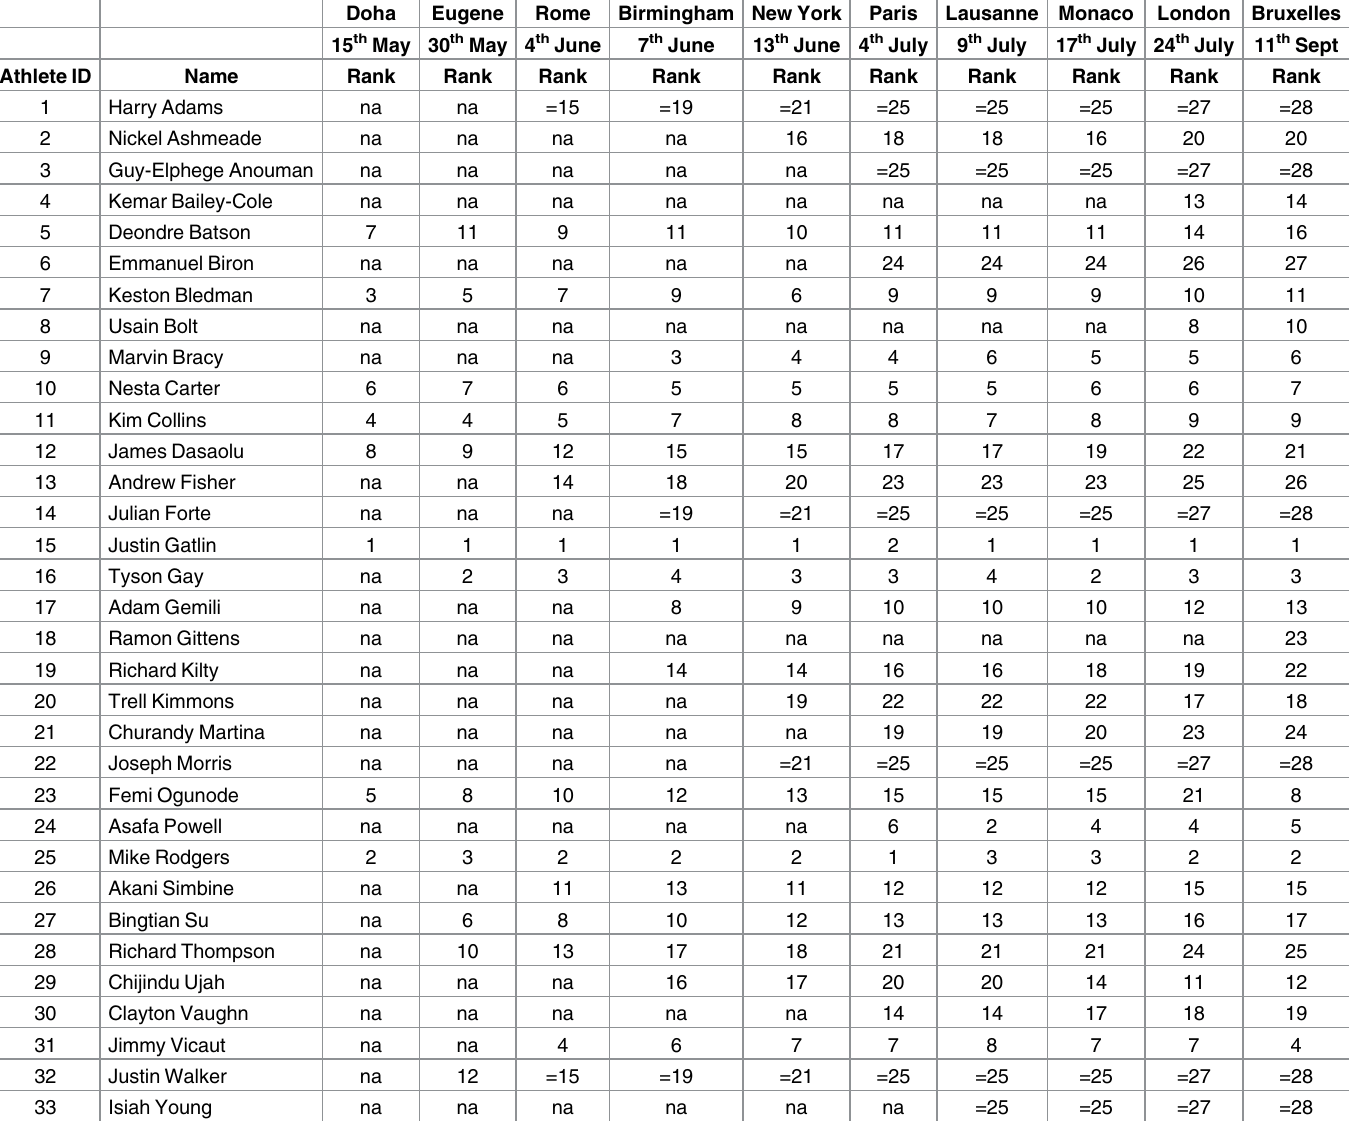
Table 3. Rank scores allocated to each competing athlete after everyrace using the PageRank